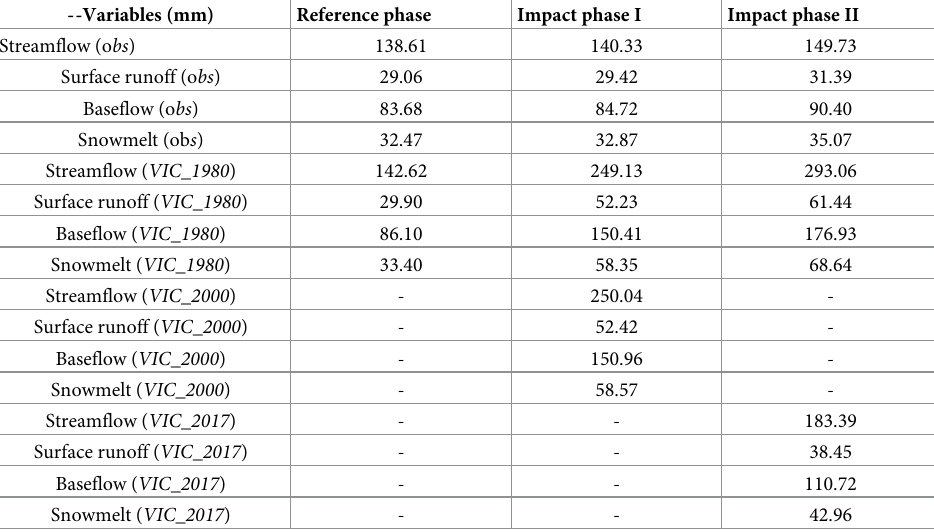
Table 3. VIC-simulated values of streamflow and its components for different impact phases and